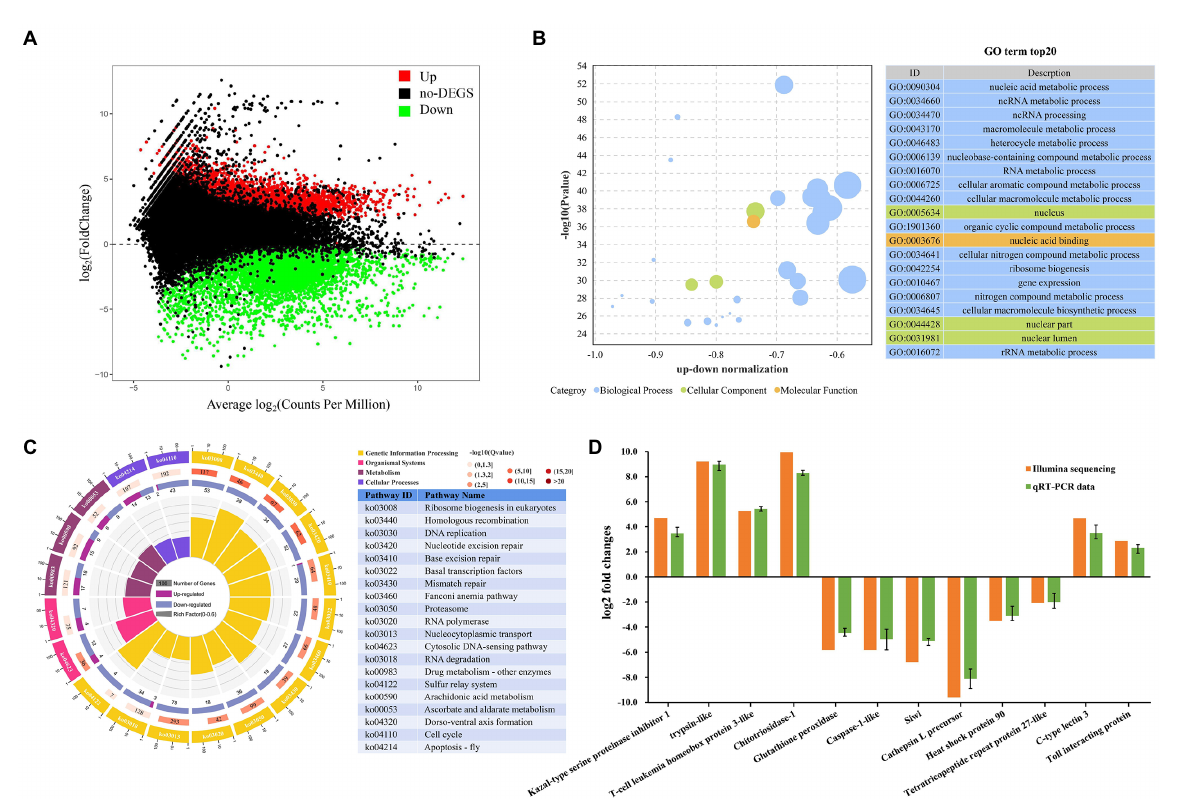
FIGURE 5 Metapenaeus ensis intestinal transcriptomic responses after DIV1 infection. (A) MA plots between DEGs in DIV1-infected and PBS group. The x-axis represents the average expression level. The y-axis represents the logarithm of multiple gene expression differences between two samples. The green and red dots represent genes with significant differences in expression. The Green dots represent down regulated gene expression, red dots represent up regulated gene expression, and black dots represent genes with no significant differences in expression. (B) Top 20 significantly enriched GO terms. Different colors show different GO categories. The x-axis represents the up-down normalization, and the y-axis